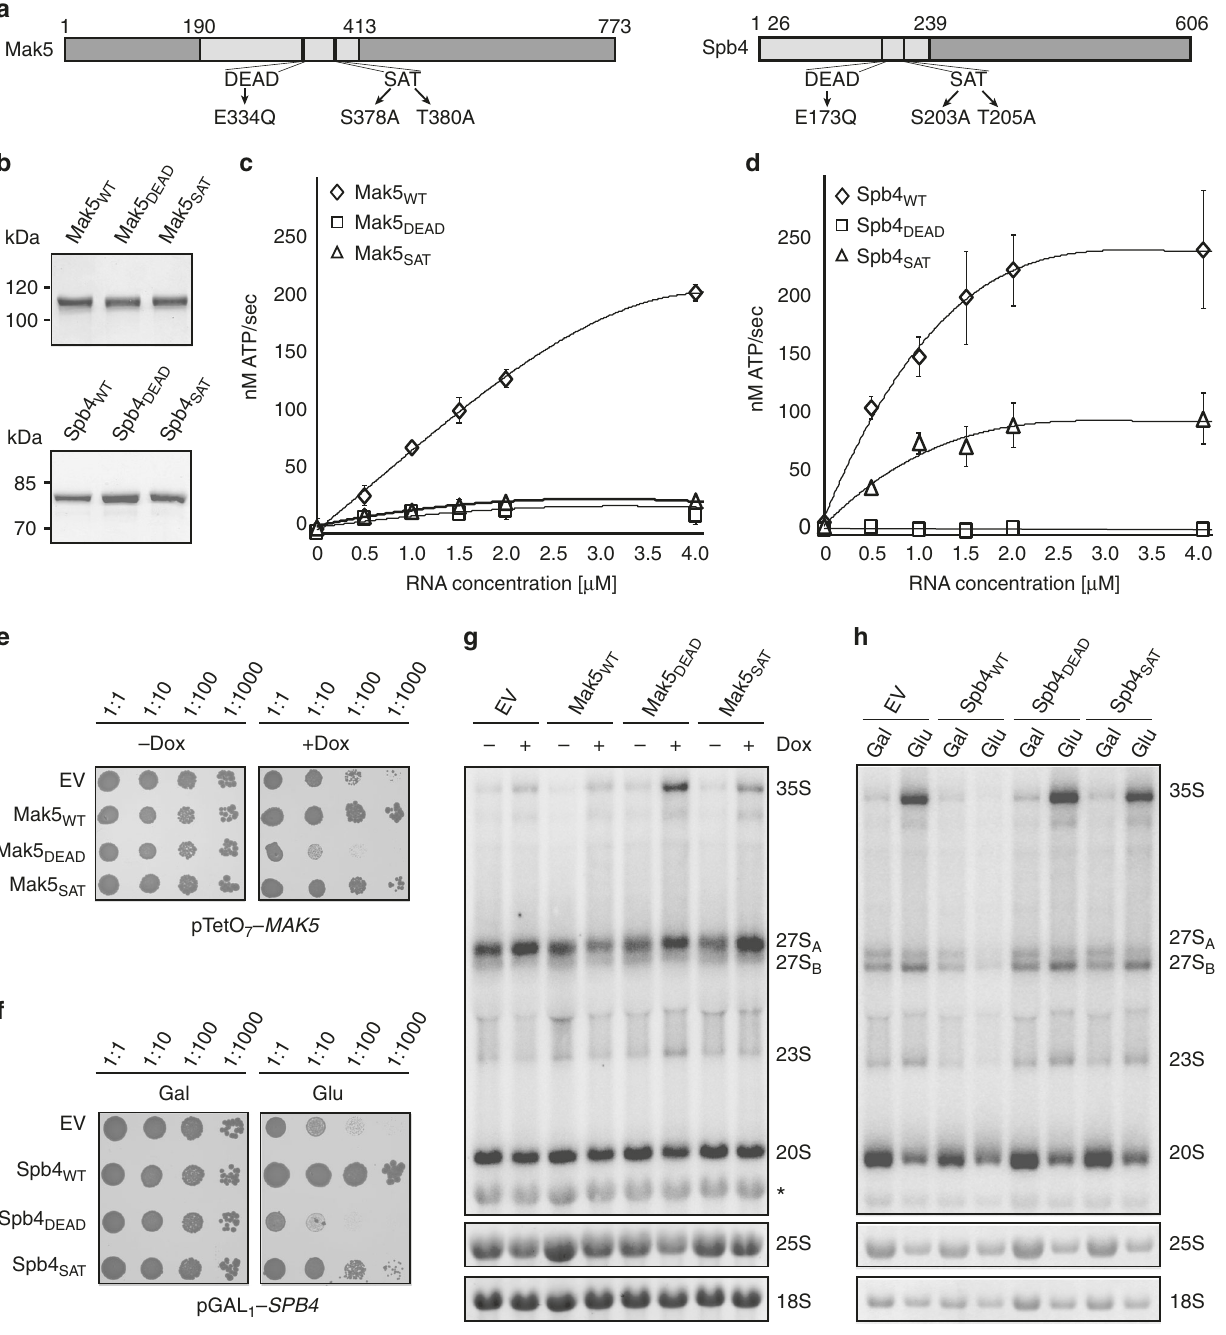
Fig. 2 The ATPase activity of Mak5 and Spb4 is required for LSU biogenesis. a Schematic view of the domains of Mak5 and Spb4. The relative positions of the conserved RecA-like domains, and DEAD and SAT motifs, are highlighted. Amino acid numbers of domain boundaries are indicated above and amino acids substitutions introduced are marked below. b His 10 -ZZ-tagged wild-type Mak5 (Mak5 WT ), Mak5 DEAD , Mak5 SAT , wild-type Spb4 (Spb4 WT ), Spb4 DEAD , Spb4 SAT were puri fi ed from E. coli , separated by SDS-PAGE and visualised by Coomassie staining. c , d The ATPase activity of recombinant Mak5 ( c ), Spb4 ( d ) and their mutants in the presence of different concentrations of RNA was monitored using NADH-coupled ATPase assays. Data from three independent experiments is shown as mean ± standard deviation. e The pTetO 7 - HA- MAK5 – derived yeast strains carrying an empty pRS415 plasmid (EV) or pRS415-based plasmids for expression of Mak5 WT , Mak5 DEAD or Mak5 SAT were grown in YPD before 10-fold serial dilution and growth on either YPD (-dox) or YPD supplemented with doxycycline ( + dox) plates. Growth was recorded after 72 h growth at 30 °C. f Growth of the pGAL 1 -HA- SPB4 yeast strain transformed with pRS415 (EV) or plasmids for expression of Spb4 WT , Spb4 DEAD or Spb4 SAT was analysed on YPG (Gal) or YPD (Glu) as in ( e ). g , h The pTetO 7 -HA- MAK5 and pGAL 1 -HA- SPB4 complementation strains were grown as in ( e , f ) before harvesting. RNAs were isolated, separated by agarose-glyoxal gel electrophoresis and pre-rRNAs were detected by northern blotting using probes hybridising in ITS1 and ITS2. Mature rRNAs were detected by methylene blue staining. The experiments presented in ( e – h ) were all performed in triplicate and representative data is